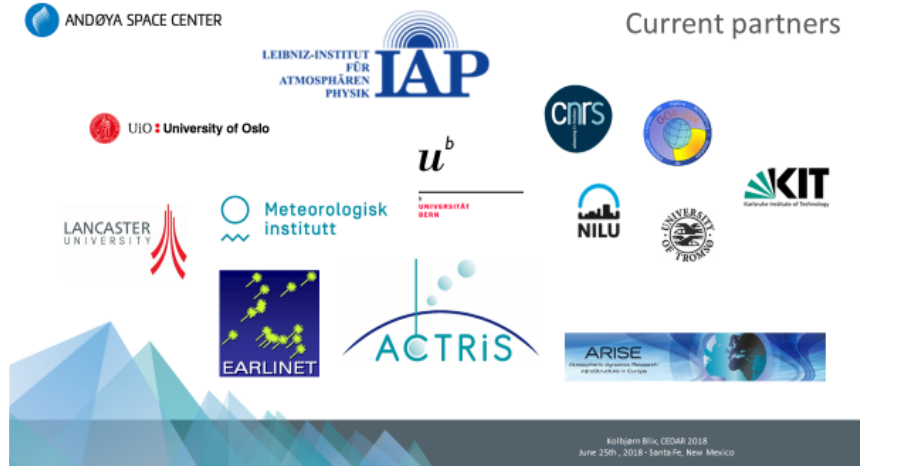
Figure 11. The present partners in